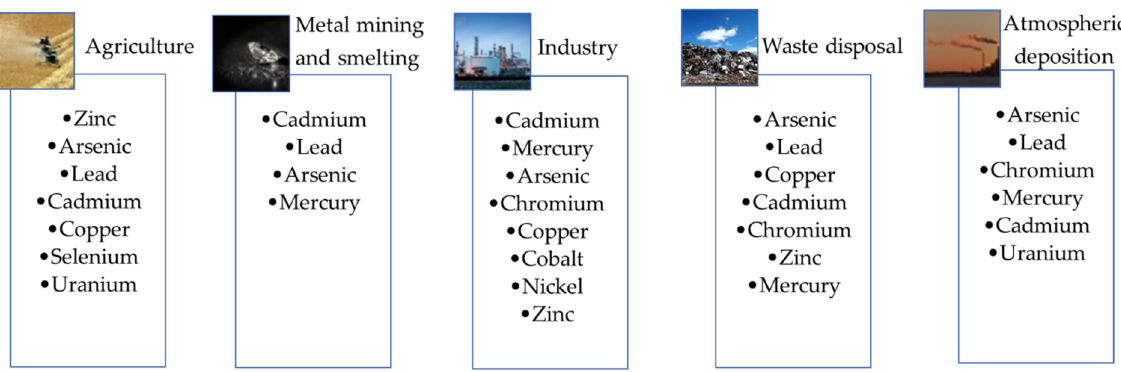
Figure 1. Anthropogenic sources of polluting metals and metalloids.